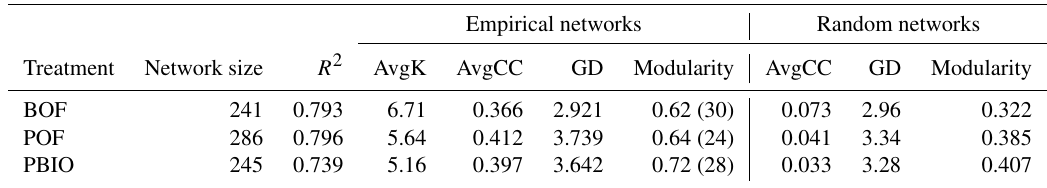
Figure 4. Relative abundance of key phyla and linear regression relationship between key phyla and disease incidence (a) . Percentage of Fusarium -related bacterial and fungal phyla in all treatments (b) . BOF – banana continuously cropped with OF application; POF – banana– pineapple rotation with OF application in the banana season; PBIO – banana–pineapple rotation with BIO application in the banana season. Different letters above the bars indicate a significant difference at the 0.05 probability level according to the Duncan test. Table 2. Topological properties of the empirical and associated random pMENs of microbial communities under BOF, POF and PBIO. BOF – banana continuously cropped with OF application; POF – banana–pineapple rotation with OF application in the banana season; PBIO – banana–pineapple rotation with BIO application in the banana season; AvgK – average connectivity; AvgCC – average clustering coefficient; and GD – average path